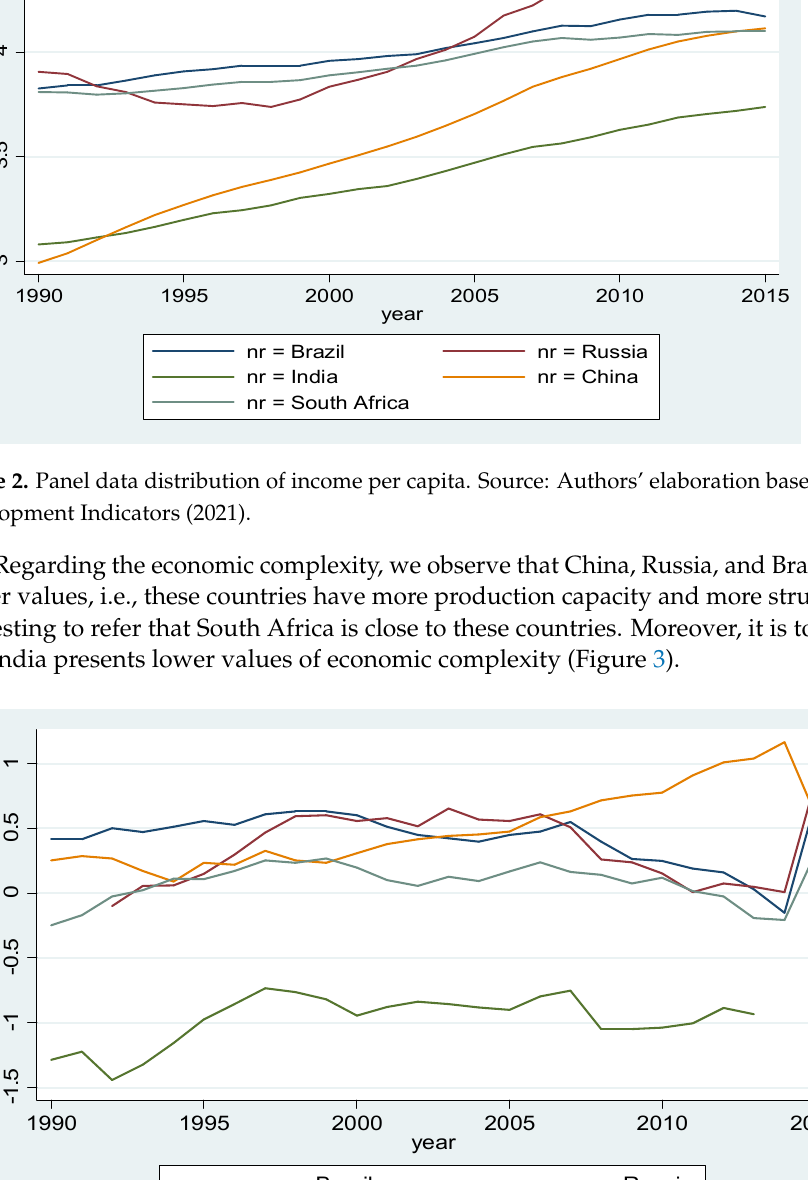
Figure 1. Panel data distribution of carbon dioxide emissions. Source: Authors’ elaboration based on World Development Indicators (2021).